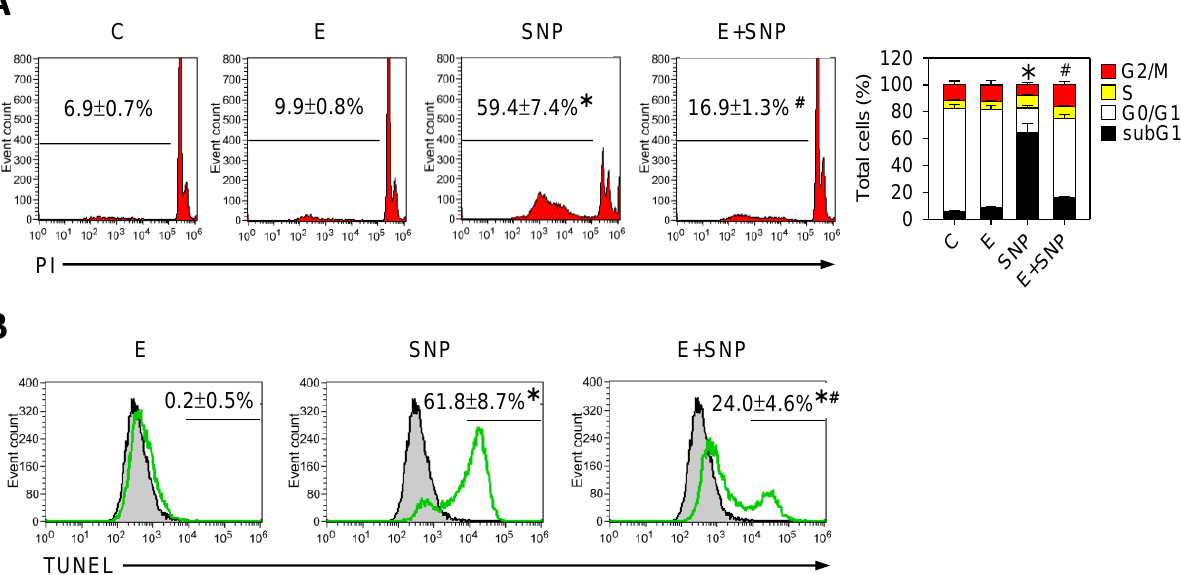
Figure 2. The effect of SNP and/or S-Equol on cell cycle progression and apoptosis of primary chondrocytes. After cells were treated with S-Equol for 24 h in the presence or absence of SNP for another 24 h, ( A ) the cell cycle distribution was determined by flow cytometry and percentage of the subG1 phase was recognized as apoptotic cells; ( B ) apoptotic cells were also determined by TUNEL. The gray peak is vehicle control and the percentage of apoptotic cells of treated cells is shown in the figure. The results are expressed as the mean ± S.D. for three separate experiments, each in triplicate. * p < 0.05 compared to the untreated control. # p < 0.05 compared to the SNP treated group.